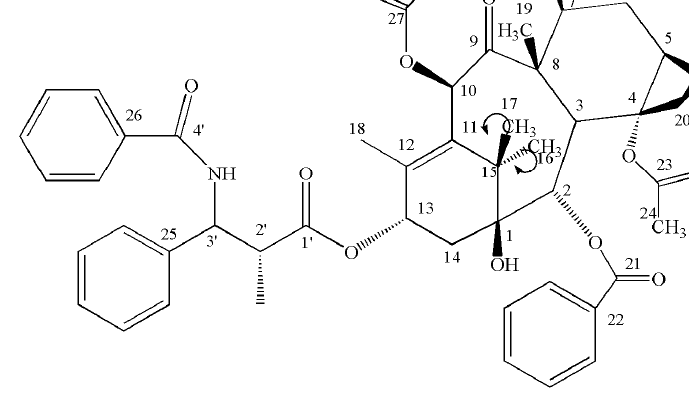
Figure 9. The change of crystalline structure of the PTX.